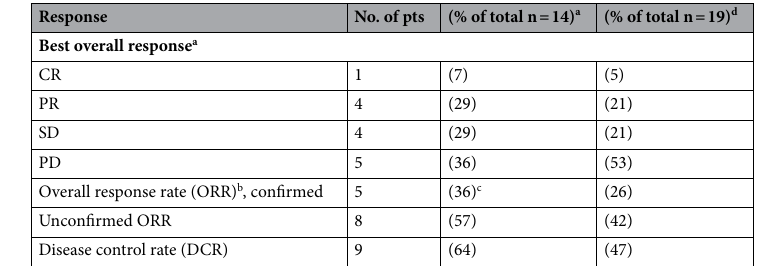
Table 4. Response to Durvalumab and Paclitaxel combination. a Determined as per RECIST 1.1. b ORR = CR + PR. c Confirmed ORR refers here to two consecutive PR or CR determined by CT with a minimum of 1 month apart while a PR followed by SD is considered SD. d With the addition of five patients who relapsed while on the paclitaxel alone